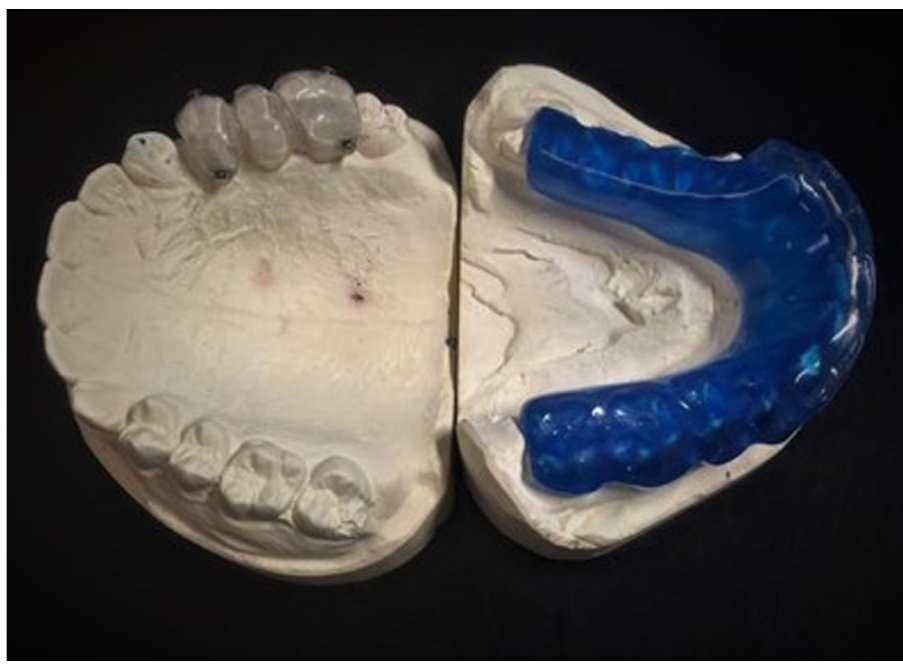
Figure 5. Working models with the upper bonded occlusal splint and lower removable bite